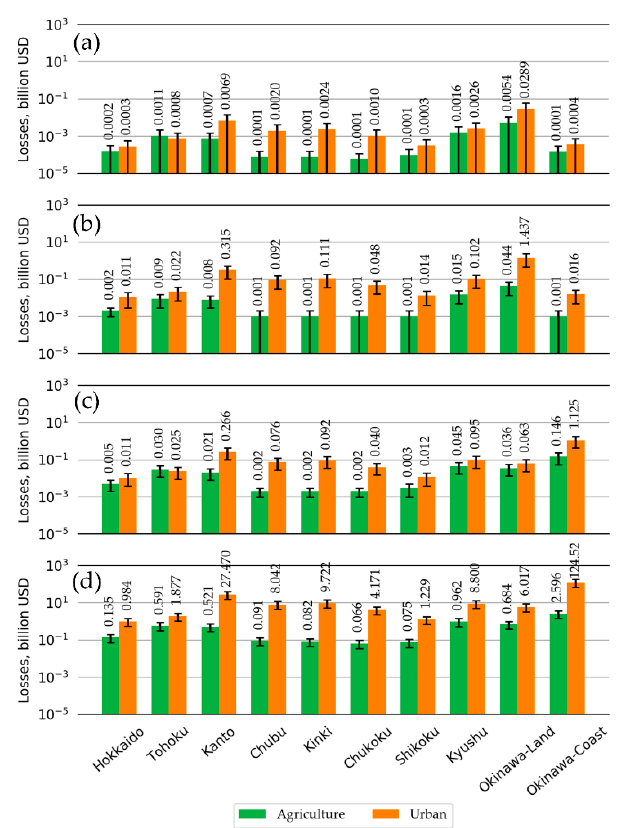
Figure 12. Impact of tsunami losses distributed in any region in Japan. ( a ) Impact of agriculture in inland areas, ( b ) impact of urban region in inland areas, ( c ) impact of agriculture in coastal areas, and ( d ) impact of urban region in coastal areas.